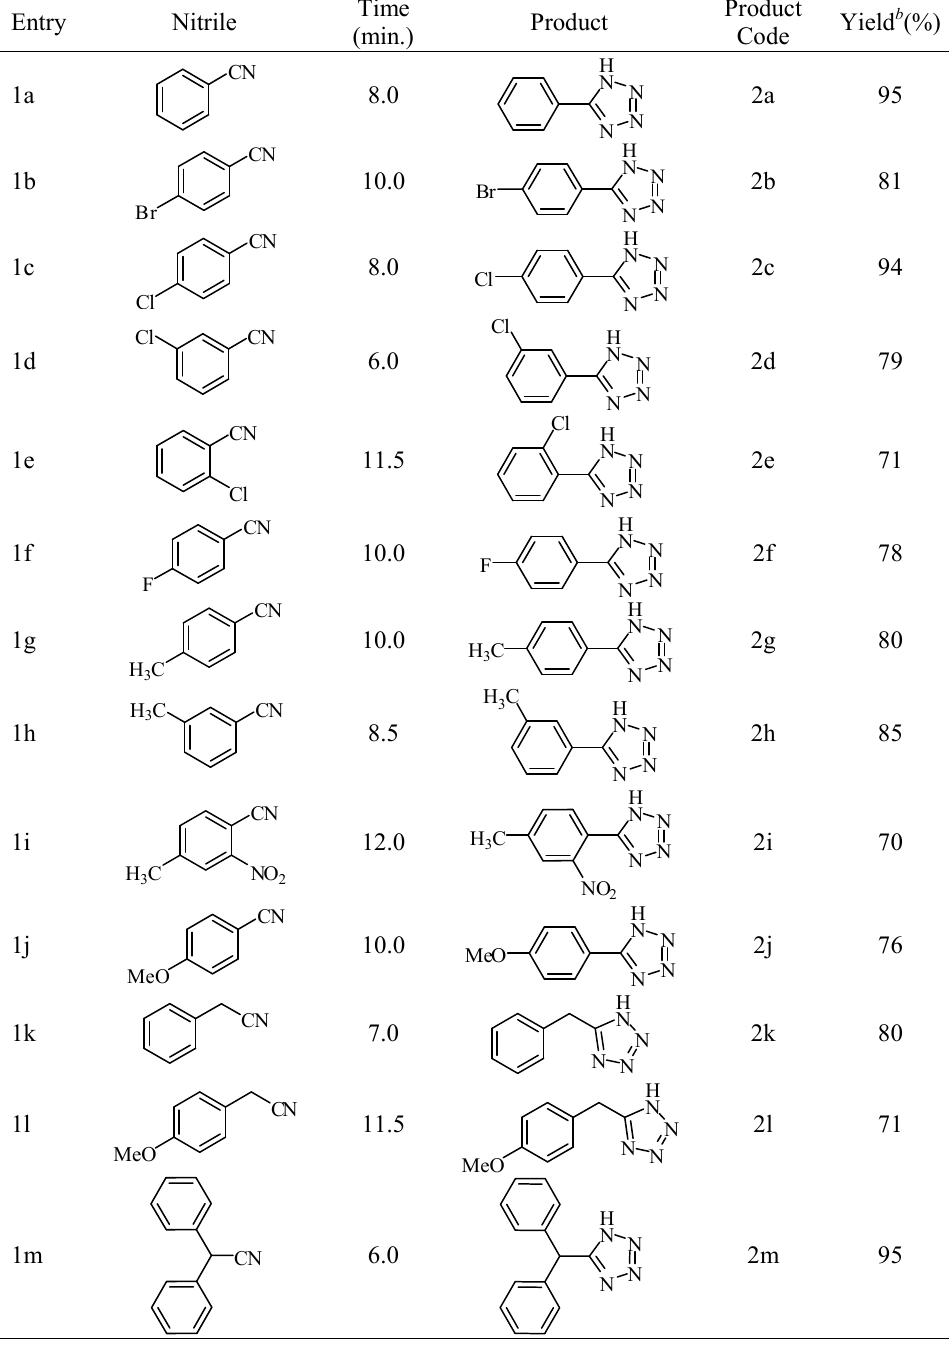
(10 mol %) under M.W. 3